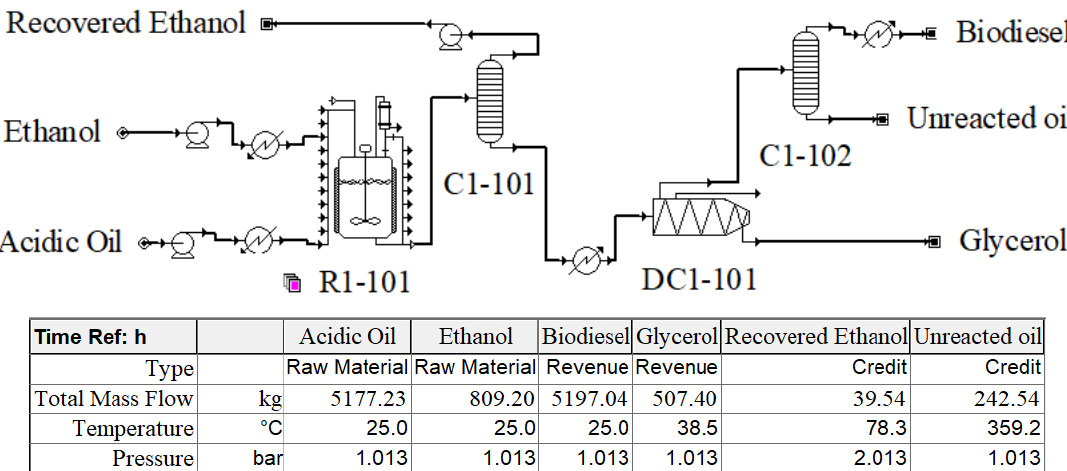
Figure 1. Technology option I: R1-101 continuous stirred-tank reactor (CSTR) to produce biodiesel, C1-101 first short cut distillation column to recover unreacted ethanol, DC1-101 centrifugal decanter to separate glycerol, and C1-102 second short cut distillation column to purify